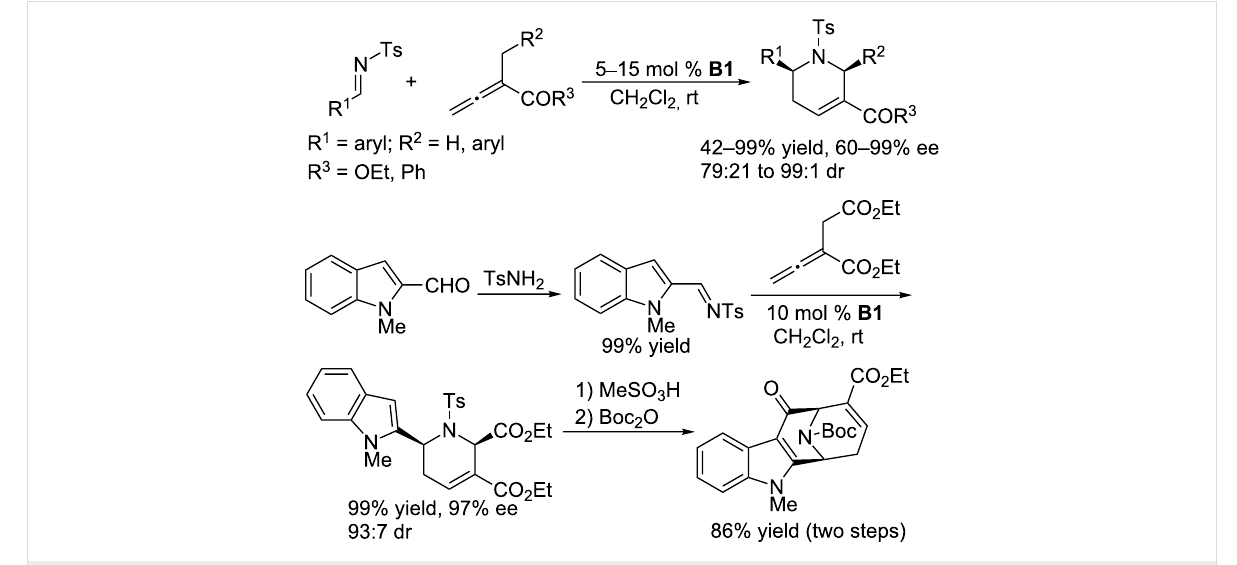
Scheme 43: Asymmetric [4 + 2] annulations catalyzed by the chiral phosphine B1